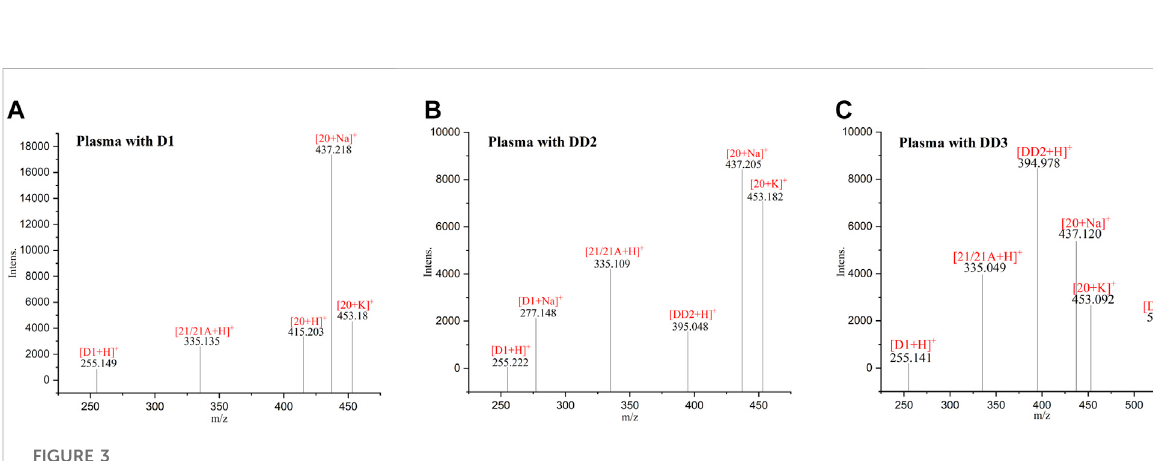
FIGURE 3 MALDI-TOF MS of the mice plasma dosed with D1 (A) , DD2 (B) and DD3 (C)